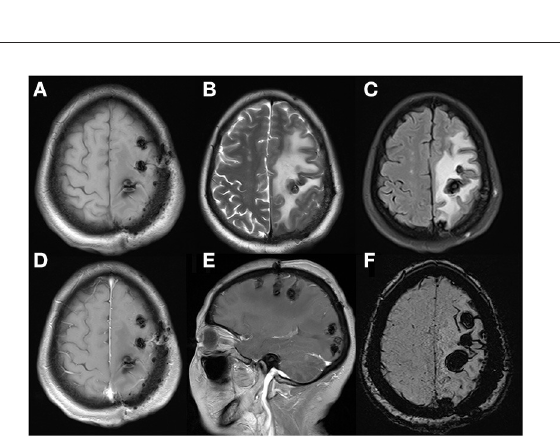
FIGURE6 These MRI performed after the second admission revealed serious edema surrounding lesions with mild midline shift, without obvious gadolinium enhancement. Axial T1WI (A) , axial T2WI (B) , FLAIR (C) , axial (D) , sagittal (E) , and enhanced T1WI and axial SWI (F)